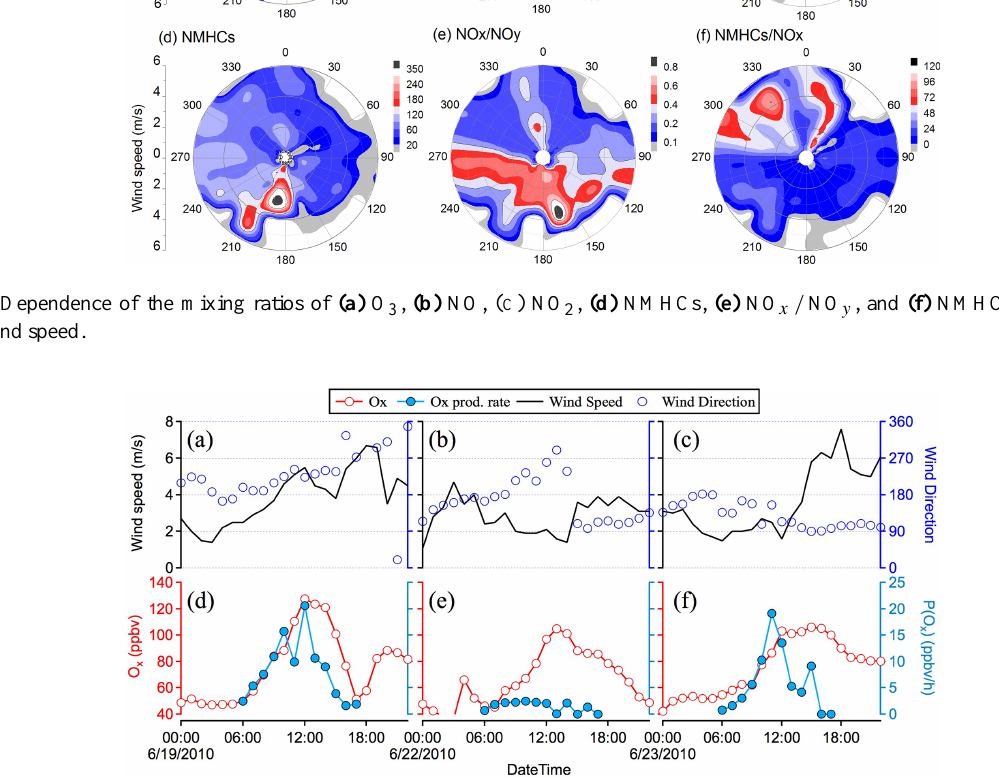
Figure 5. Diurnal variations in O x concentration, P(O x ) , and wind speed and direction for three typical O 3 pollution cases on 19, 22, and 23 June during the field observation